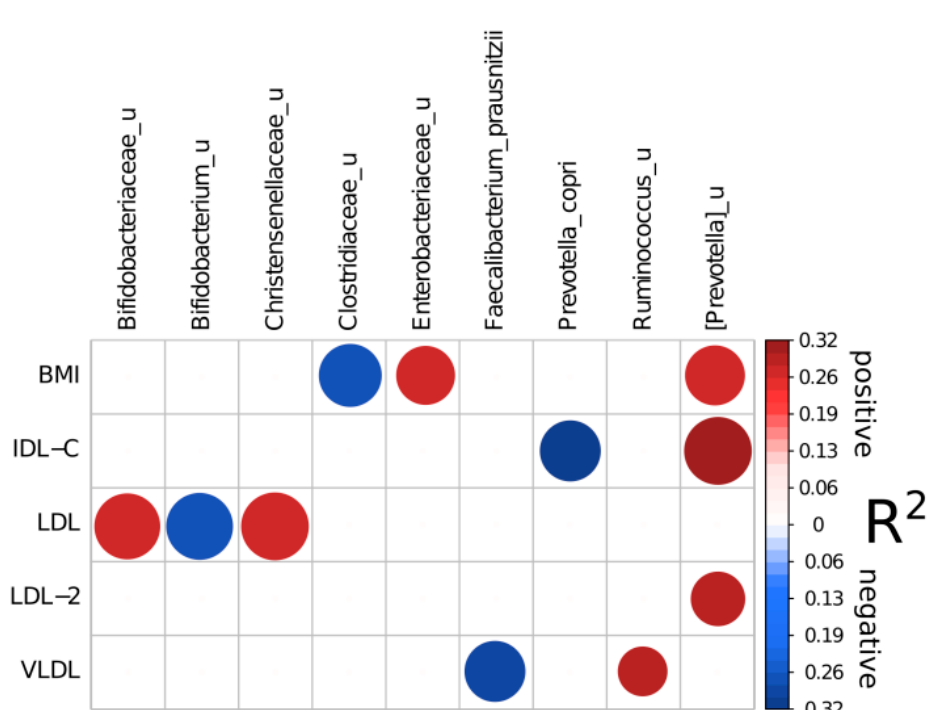
Figure 2. Reliable associations between microbiome composition, subfractional spectrum of apo B-containing lipoproteins and BMI according to Selbal analysis (see Section 2). Circles sizes are related to taxon reproducibility and circles colors to model R2. Numerator parts of balance are colored with red and denominator with blue. Table 5. Gut microbiota diversity association with clinical